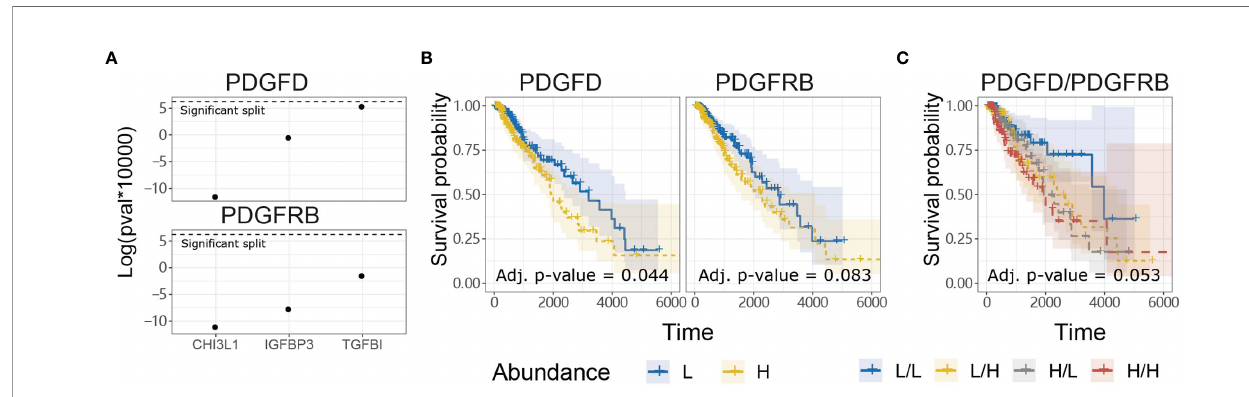
FIGURE 3 | PDGFD expression is associated with tumor invasion and poor prognosis compared to PDGFRB in TCGA LGG dataset. (A) Tumor expression of PDGFD and PDGFRB were positively correlated with the expression of TGFBI, IGFBP3, and CHI3L1 which play important roles in glioma invasion and migration. (B) KM survival curves constructed for PDGFD or PDGFRB expression in LGG tumors. (C) KM curves constructed for combinations of PDGFD and PDGFRB abundance in LGG